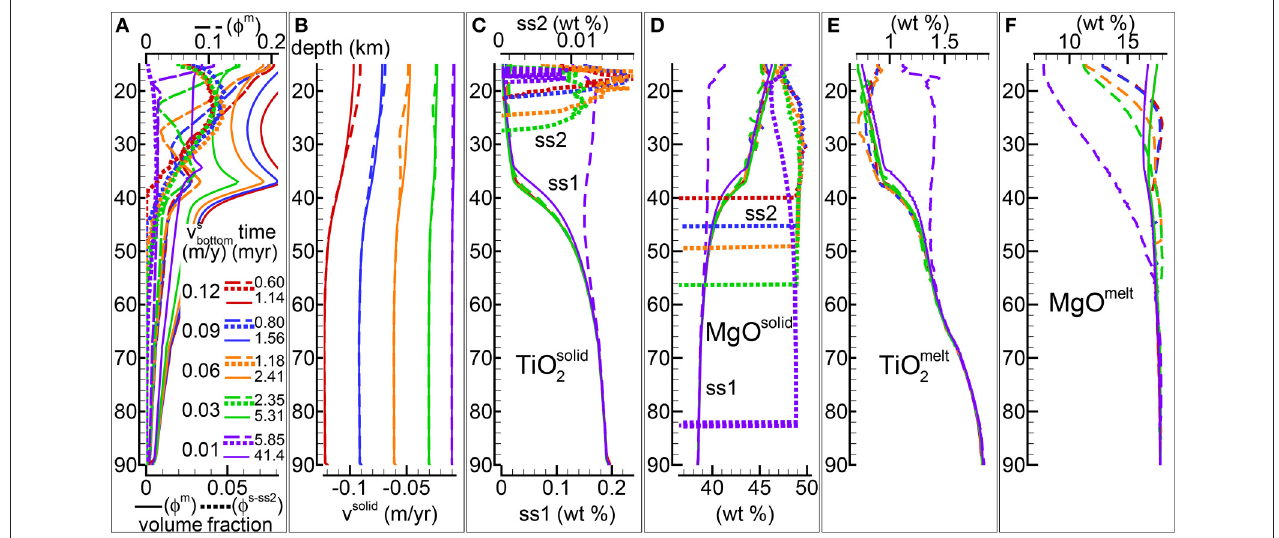
FIGURE 6 | DFM simulations assuming a different velocity of the solid at the bottom (negative upwards), − 0.12 m/yr (red lines), − 0.09 m/yr (blue lines), − 0.06 m/yr (green lines), − 0.03 m/yr (orange lines), − 0.01 m/yr (purple lines). Solid viscosity model: µ s = µ s 0 with µ s 0 = 1 e 21 Pa s, permeability constant C = 1e9 m − 2 , temperature at the bottom 1,450 ◦ C. (A) Melt volume fraction vs. depth at 2 different times (solid and dashed lines). Earliest time indicates approximately the largest amount of melt reaching the top side. Dotted line is the volume fraction of solid in sub-system 2. (B) Velocity of the solid matrix. (C–F) Variation of solid and melt composition (wt %). (C) TiO 2 in the residual solid (ss1) and solid in sub-sys 2 (ss2, dotted lines). (D) MgO in the residual solid (ss1) and solid in sub-sys 2 (ss2, dotted lines). (E) TiO 2 in melt. (F) MgO in melt. Data files included in the zip file max-front2-data.zip , PHASE3B.YRC1.DAT ( − 0.03 m/yr), PHASE3B-P.YRC13.DAT ( − 0.06 m/yr), PHASE3B-P.YRC15.DAT ( − 0.09 m/yr). Data file PHASE3B-P.YRC22.DAT ( − 0.01 m/yr) is included separately. See the Supplementary Material for additional